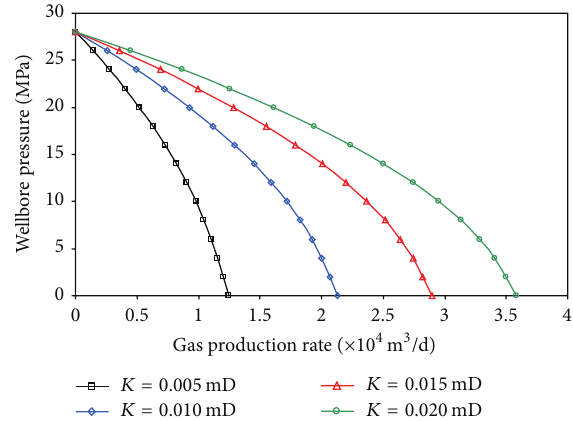
Figure 8: Effect of fracture conductivity 𝑘 𝑓 ⋅ 𝑊 𝑓 on productivity.